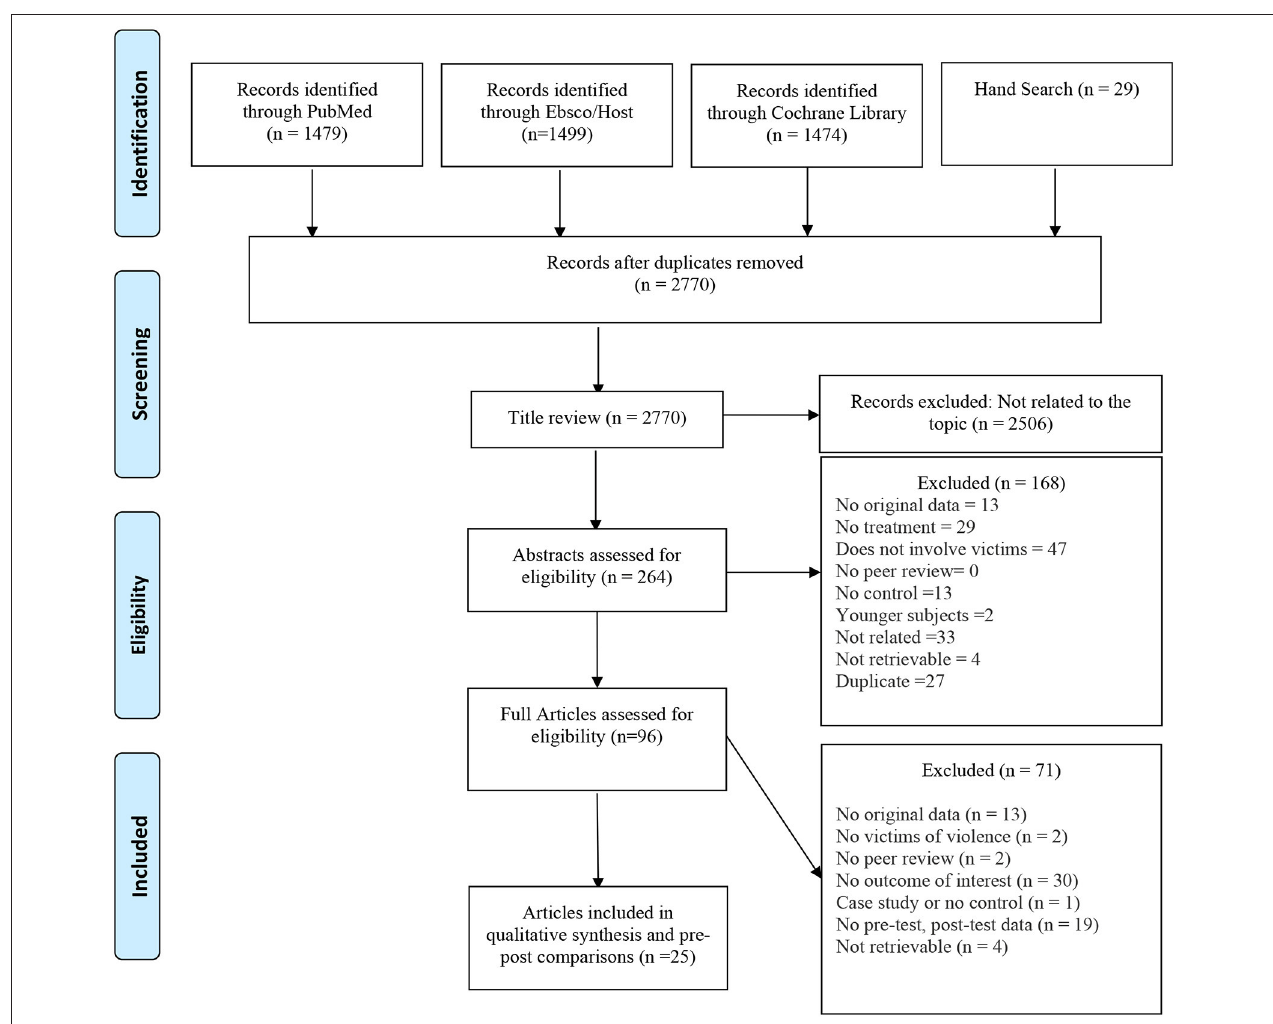
FIGURE 1 | Prisma flow diagram for included studies of systematic review and meta-analysis for treatments for female victims of intimate partner